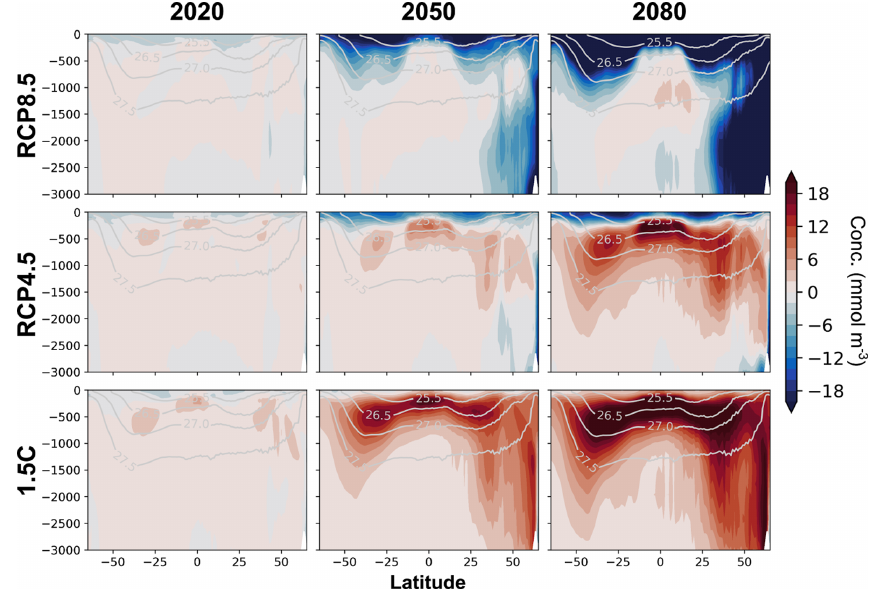
Figure 4. Ocean component model output of the global zonal mean deviation of anthropogenic carbon concentration (mmolm − 3 ) from the ∗ C ant ). Rows and columns are the same as in Fig. 1. Positive regions indicate faster carbon historical scaling of anthropogenic carbon ( C ant − accumulation than historical scaling; negative regions indicate slower accumulation. Contour lines are surfaces (kgm − 3